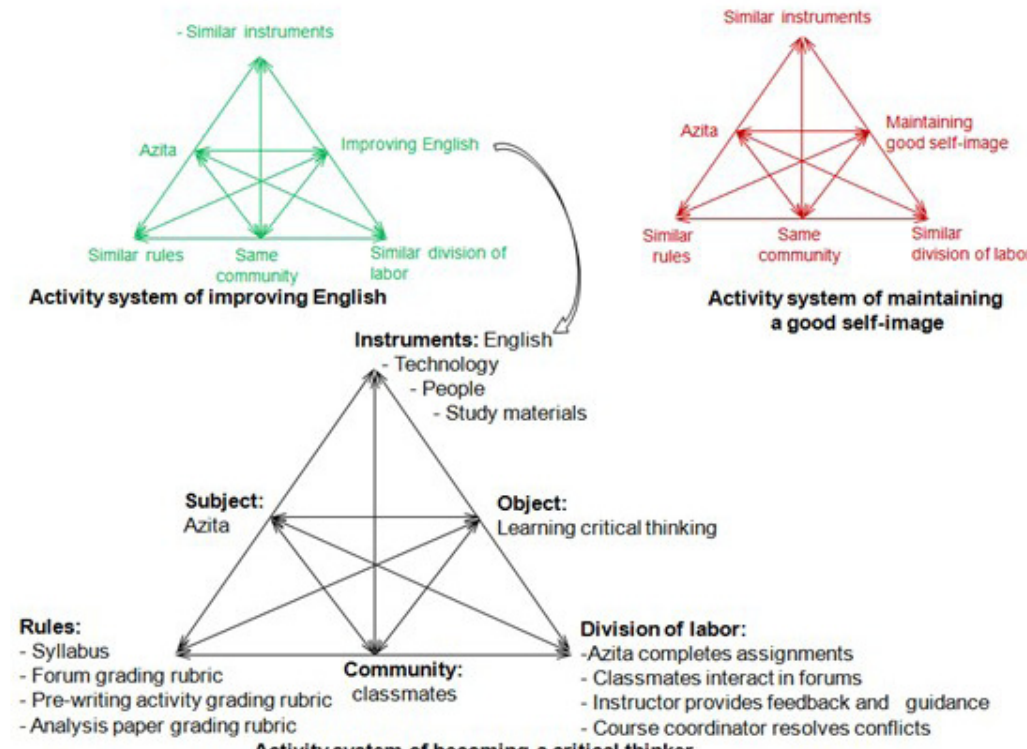
Figure 6. Azita’s three activity systems in the critical thinking